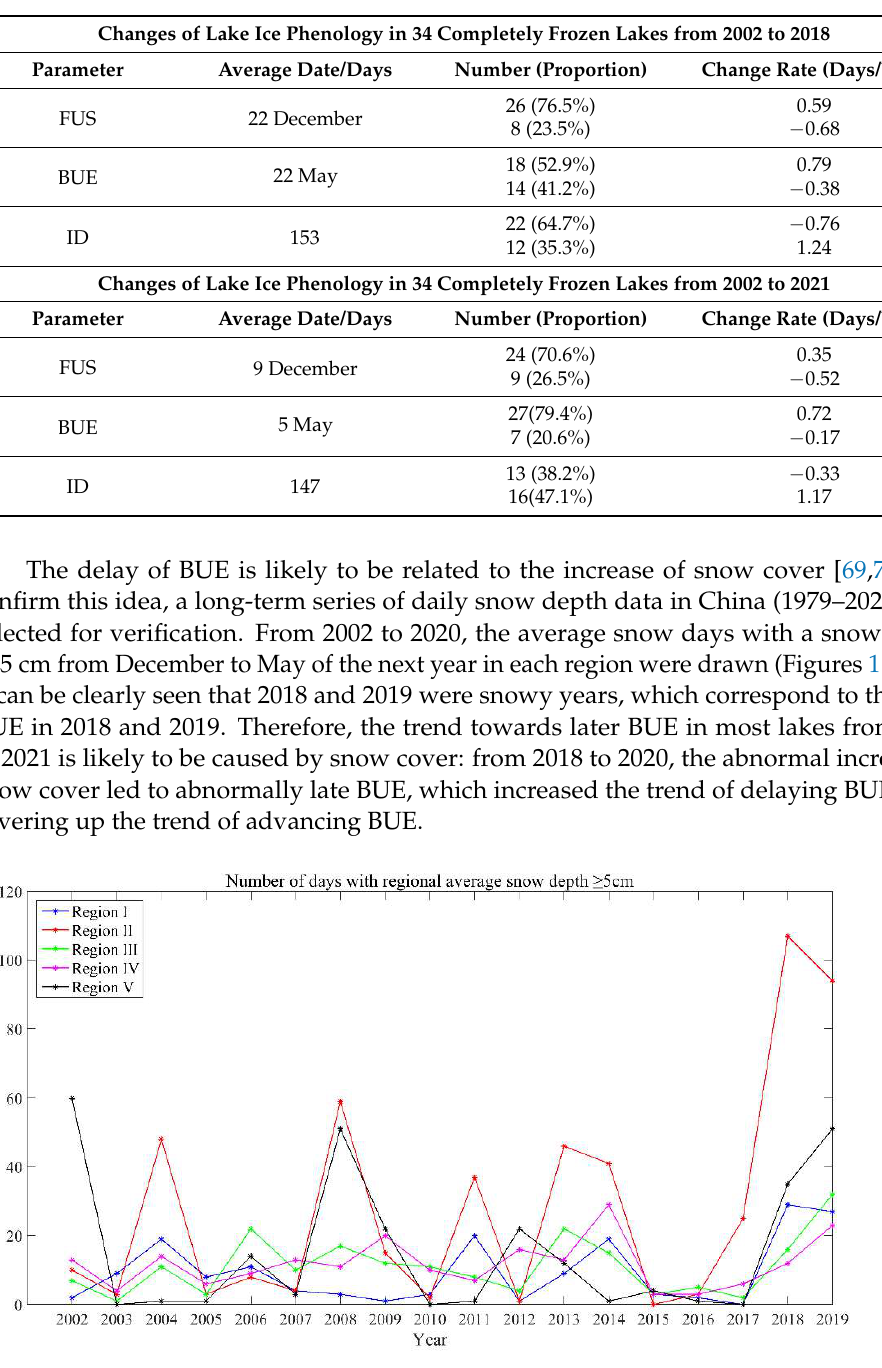
Table 6. Comparison of trend analysis results between 2002–2018 and 2002–2021. The number (proportion) of lakes with earlier/later FUS, BUE, and with shorter/longer ID are determined. Their average date or days and change rate are also shown.